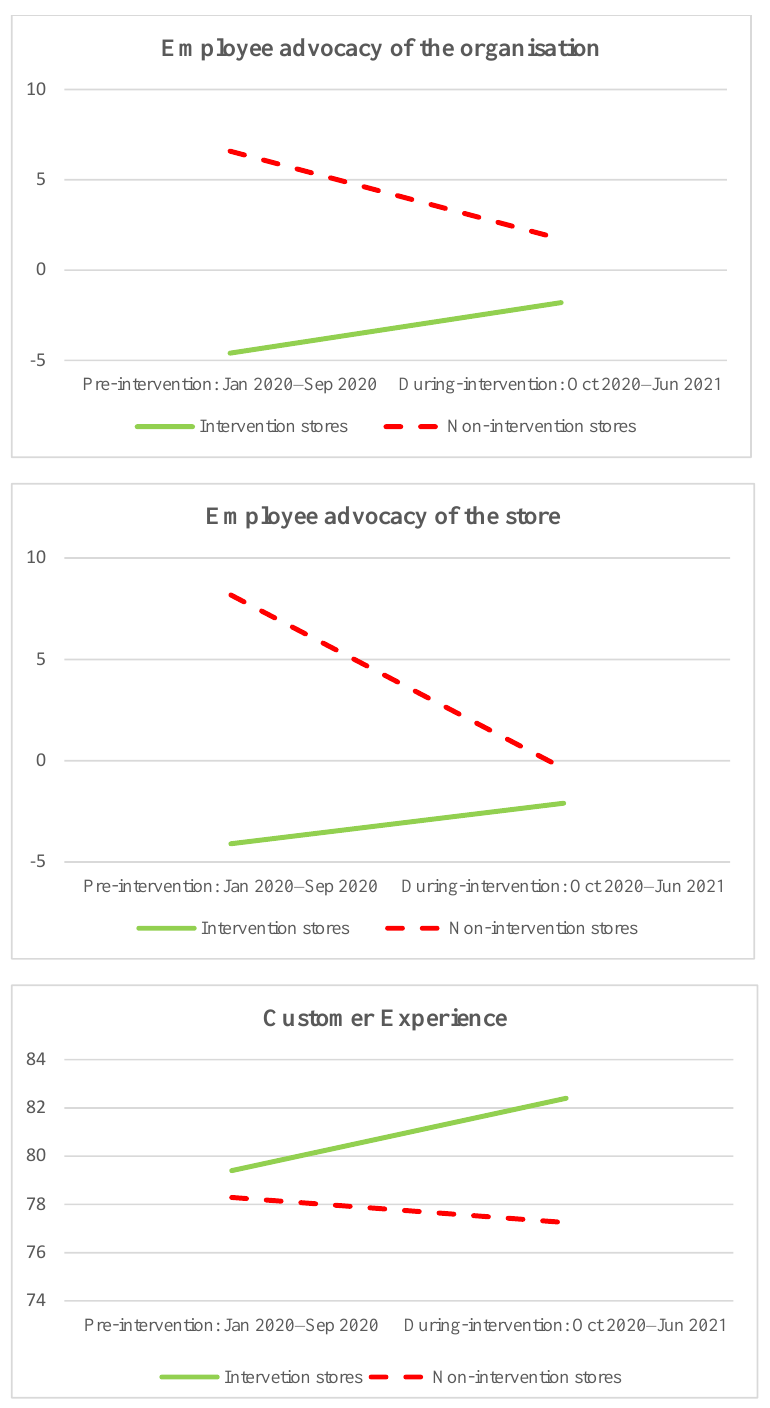
Figure 2. A comparison of employee advocacy and customer satisfaction scores between intervention stores and stores of the same organisation that were not exposed to intervention.